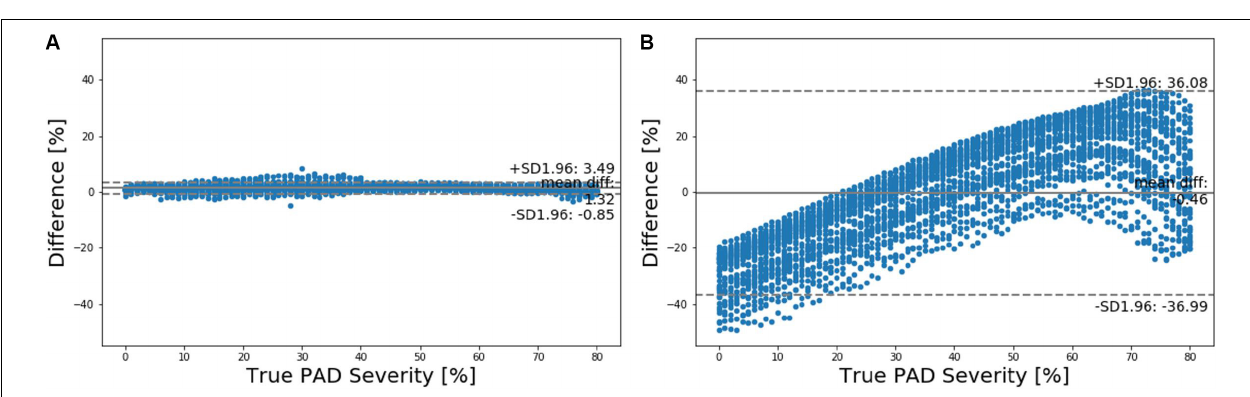
FIGURE 6 | Bland-Altman plots between true PAD severity vs. PAD severity predicted by (A) deep learning-based pulse waveform analysis approach and (B) ankle-brachial index